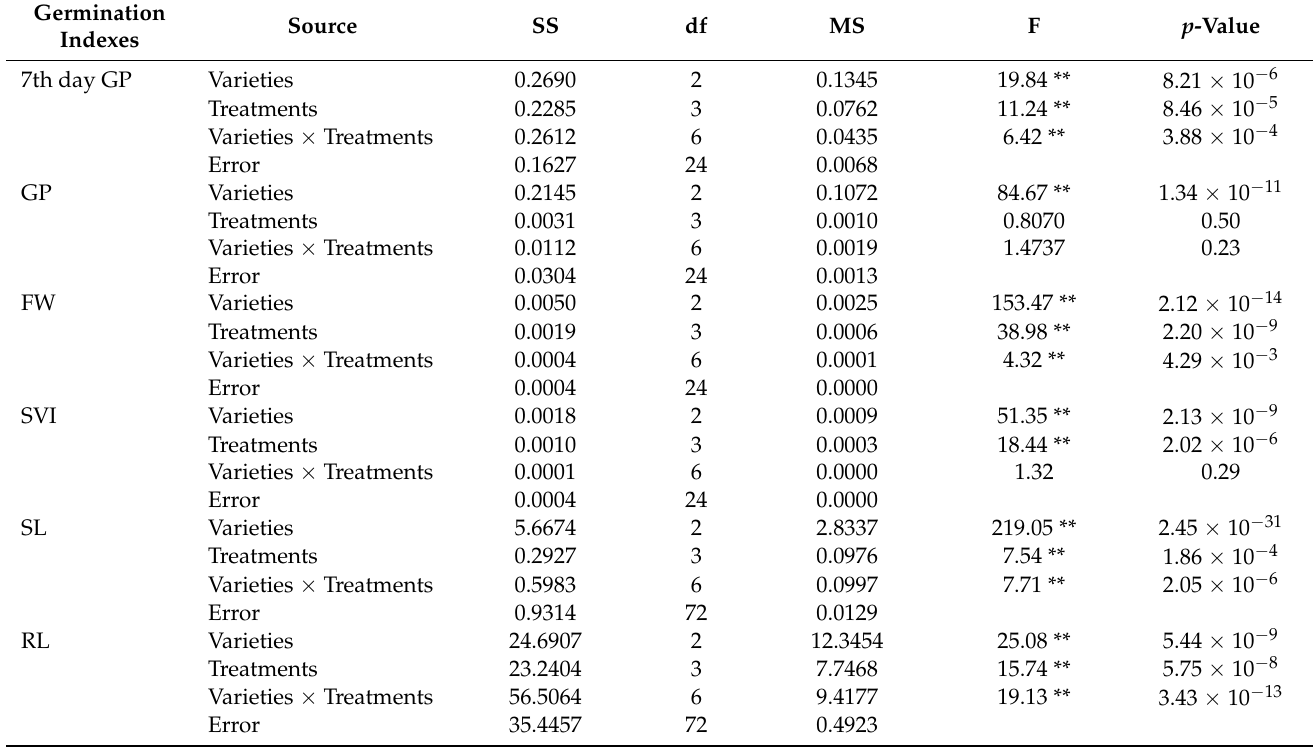
Table 1. Two-way ANOVA of priming treatments and varieties on the germinability of pepper seed.